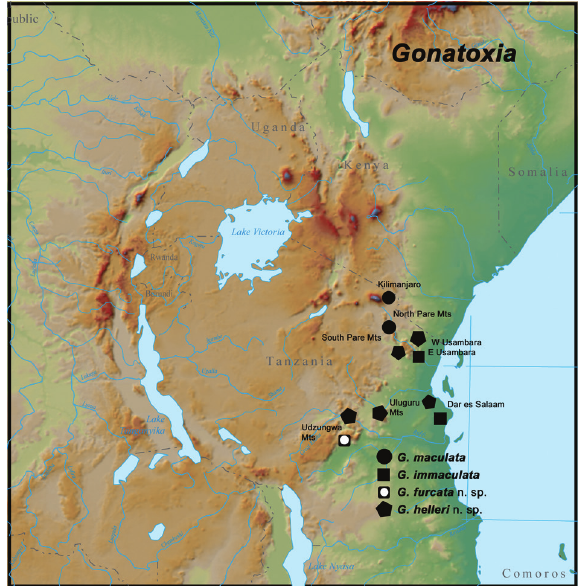
Figure 24. Map of East Africa with distribution of Gonatoxia species. G. maculata in Somalia is not indicated since locality information is